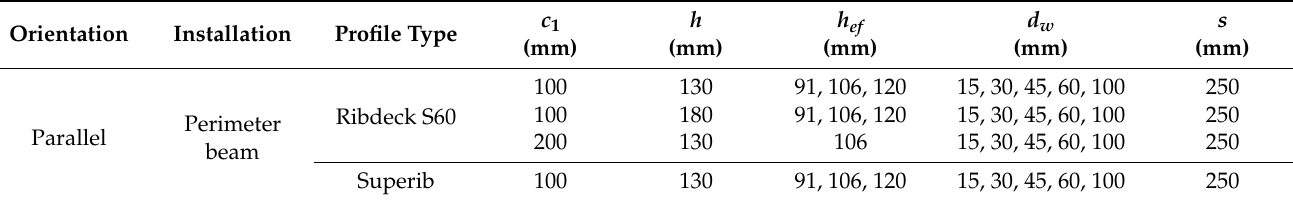
Table 3. Series 1—anchor channel in the perimeter beam, parallel to the steel decking profile.